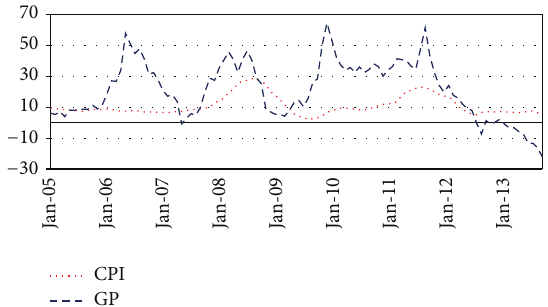
Figure 4: Gold Prices (%). Note: this figure shows the evolution of the year-on-year growth rates of overall CPI and of the average of the 108 Gold Price (GP) series. All of the series are